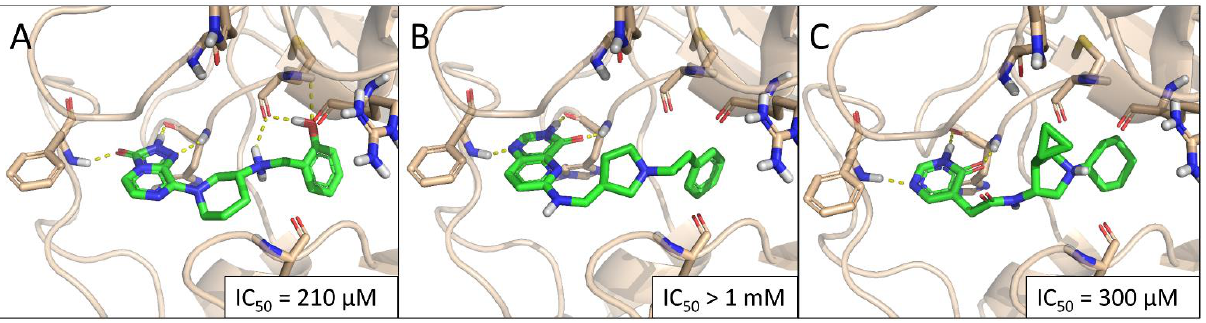
Figure 4. Predicted binding poses of the hit compounds C13 ( A ), C17 ( B ), and C19 ( C ).